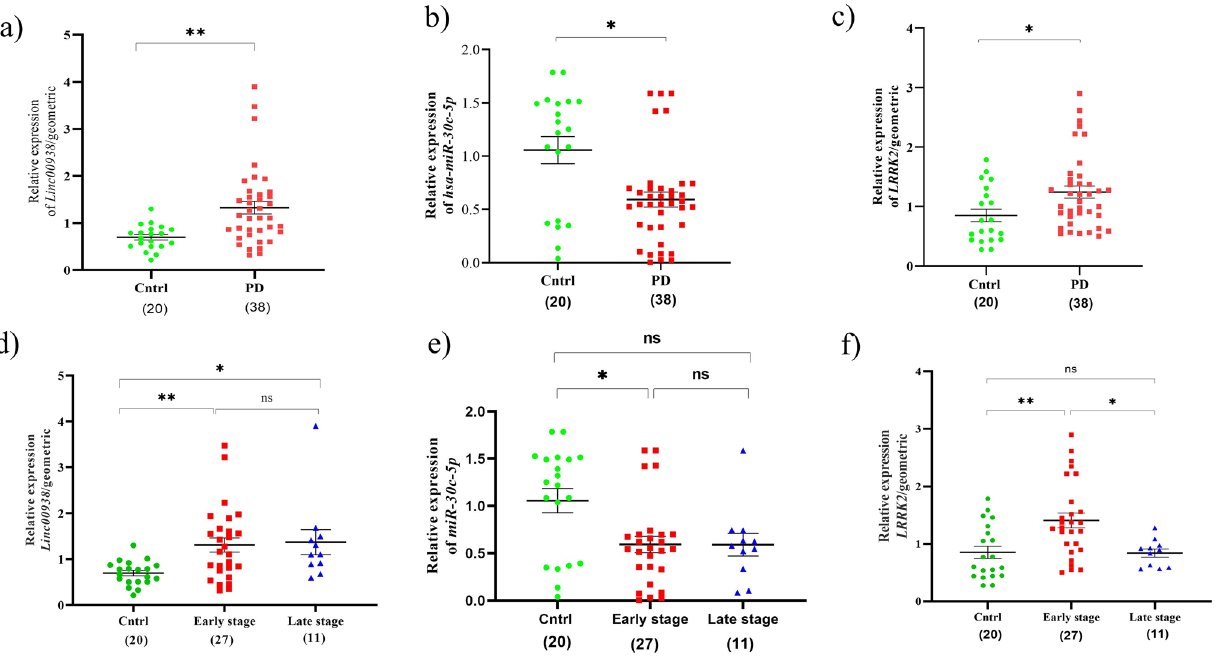
Figure 3. Assessment of the relative RNA expression related to lncRNA, miRNA and mRNA as formed in the second regulatory network. QRT-PCR analysis of the RNA expression in the PBMC of: ( a – c ) control subjects and PD patients. ( d – f ) control subjects and PD early and late stage groups, based on the UPDRS score. All data are represented as mean ± SEM (**p ≤ 0.01, *p ≤ 0.05, and ns p > 0.05).